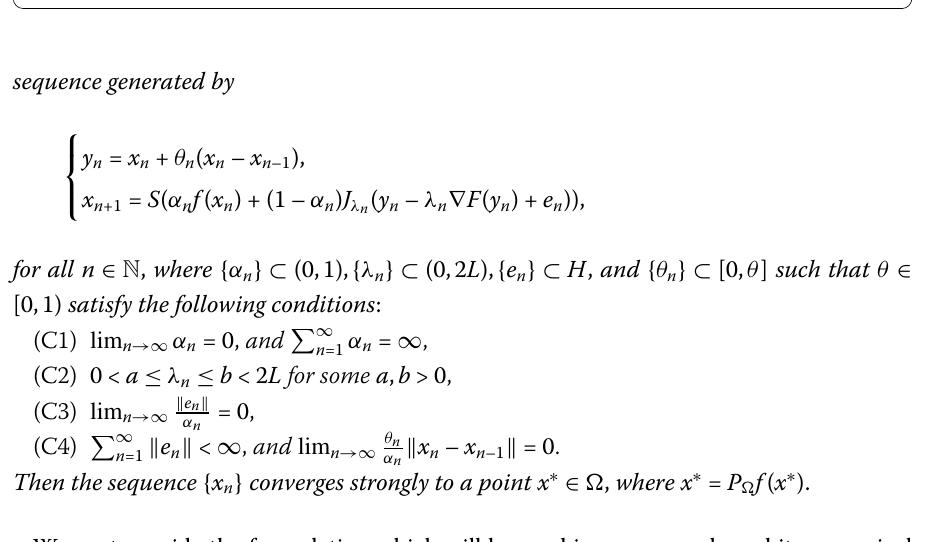
Figure 4 Convergence behavior of the error sequences {(cid:13) x n +1 – x n (cid:13) 2 } for all the best choice types A2, B1, and C2 in Example 4.5